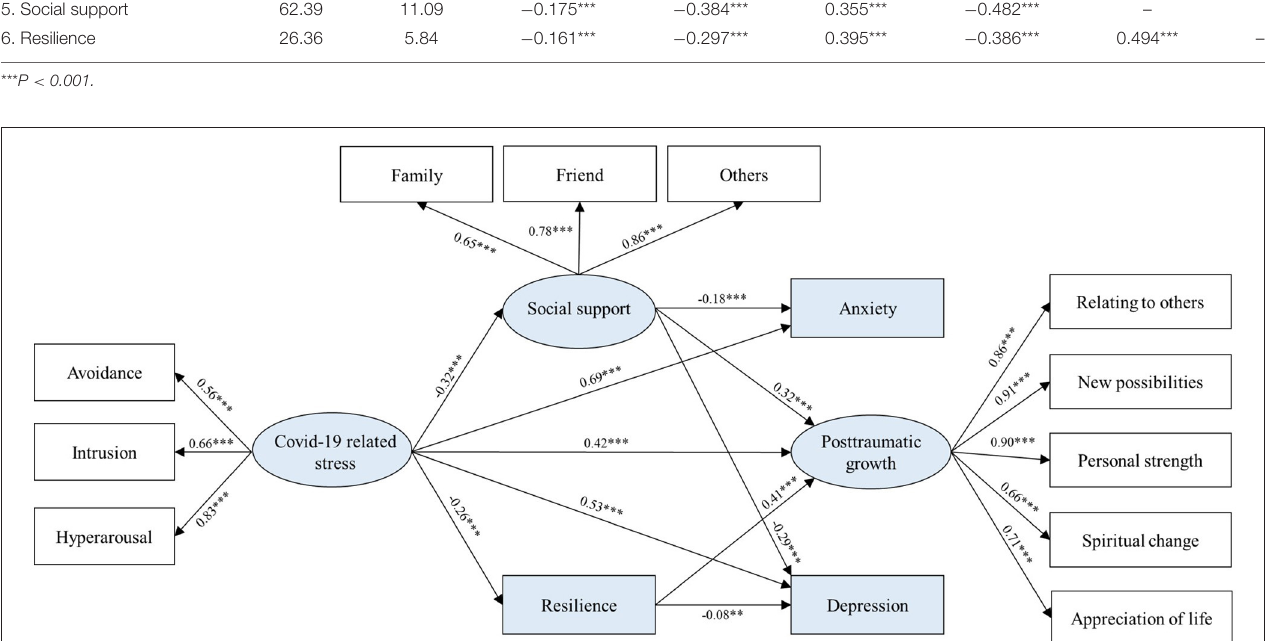
FIGURE 3 | The mediating chain effect of social support and resilience in the relationship between the COVID-19 related stress and mental health outcomes (depression, anxiety, and posttraumatic growth). Sex, whether in only-child family, age, education, household income, and career were included as covariates. Standardized coefficients are reported. ** P < 0.01, *** P <